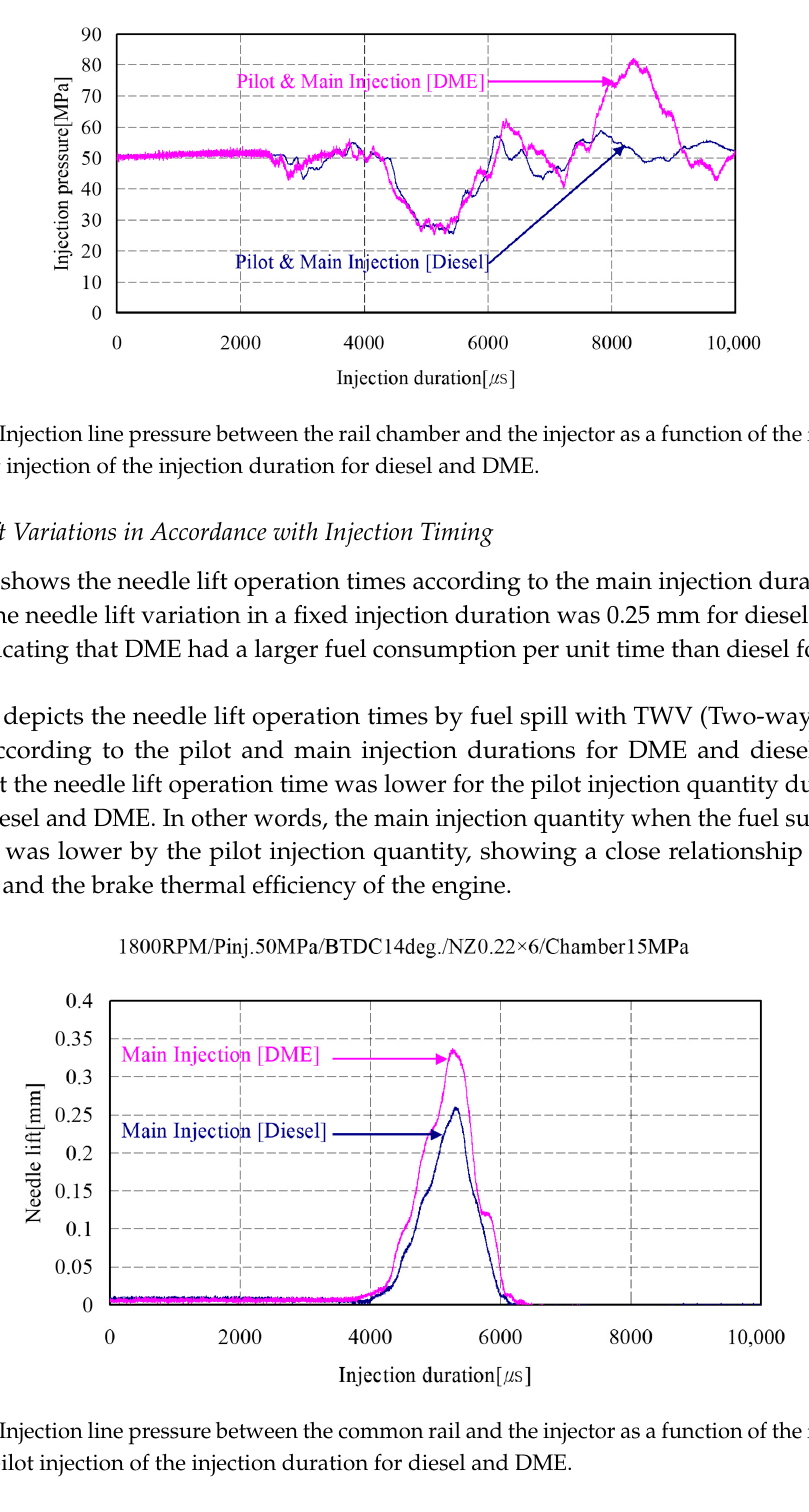
Figure 5. Injection line pressure between the fuel rail and the injector as a function of the following: without pilot injection of the injection duration for diesel and DME.